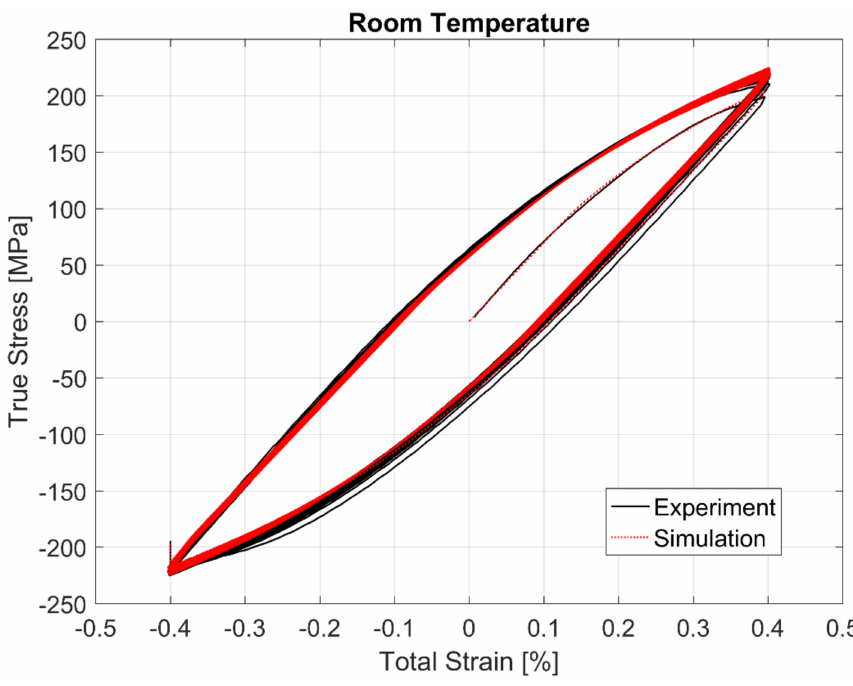
Figure 20. Experimental vs. visco-plastic model prediction at room temperature (RT).